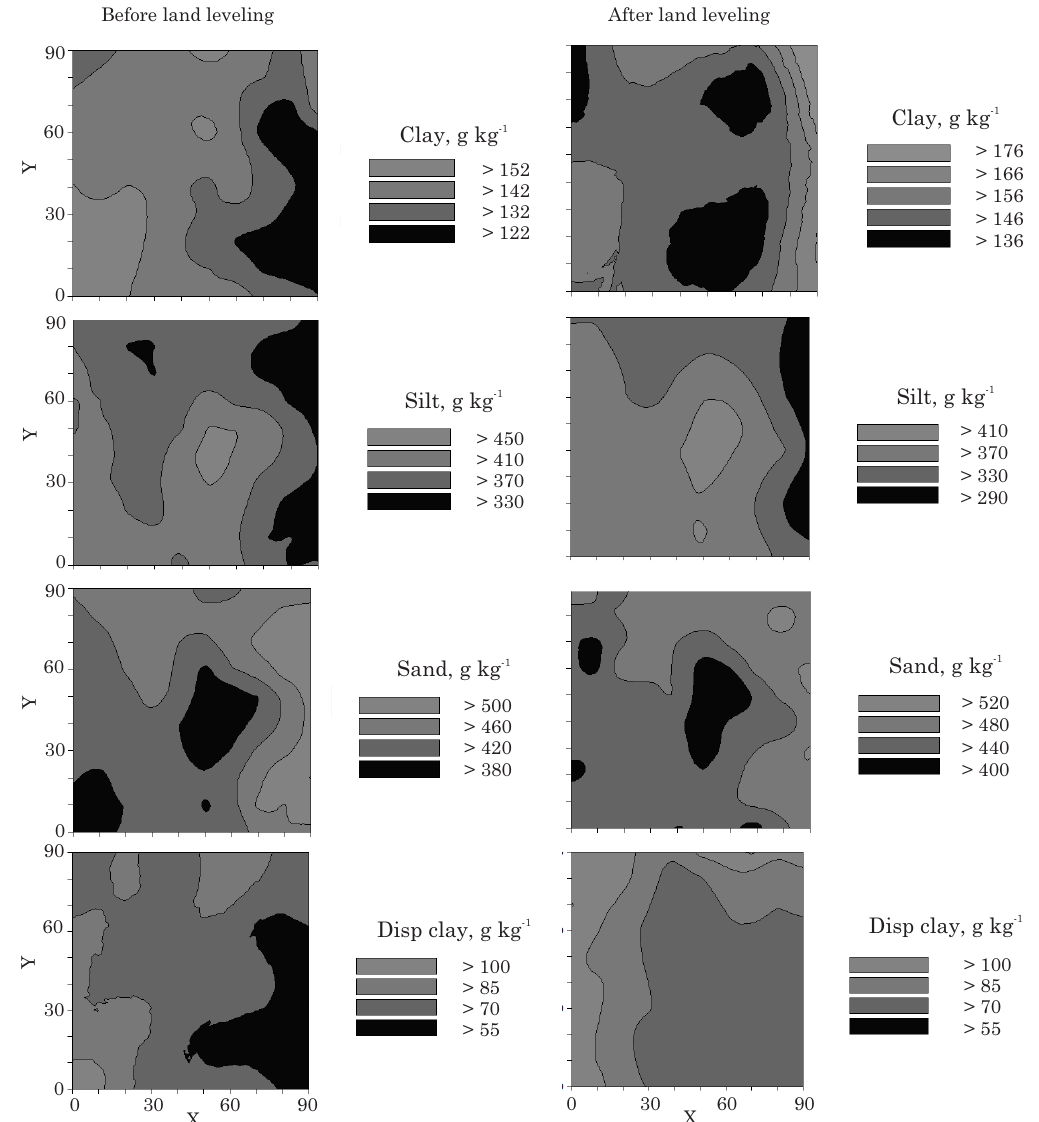
Figure 2. Maps of the spatial distribution of concentrations of clay, silt, sand and dispersed clay in water (Disp clay), before and after land